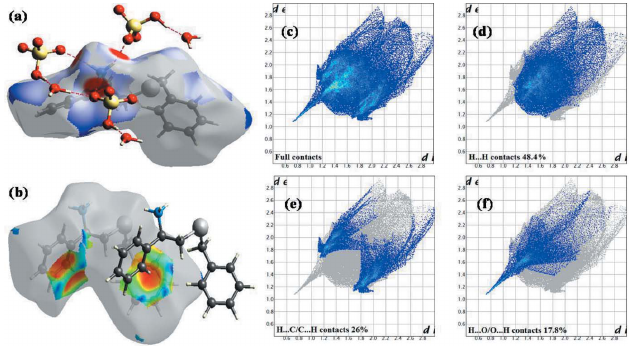
Figure 4 Hirshfeld surfaces comprising ( a ) d norm surface, ( b ) shape-index and ( c )–( f ) fingerprint plots of the cation.